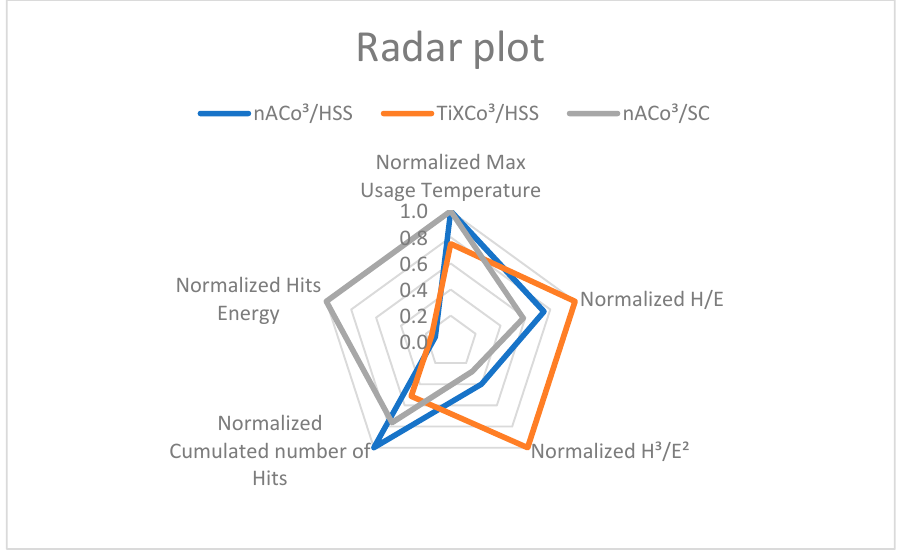
Figure 14. Graphic radar representation of acoustic emission parameter results in comparison with values from nanoindentation.